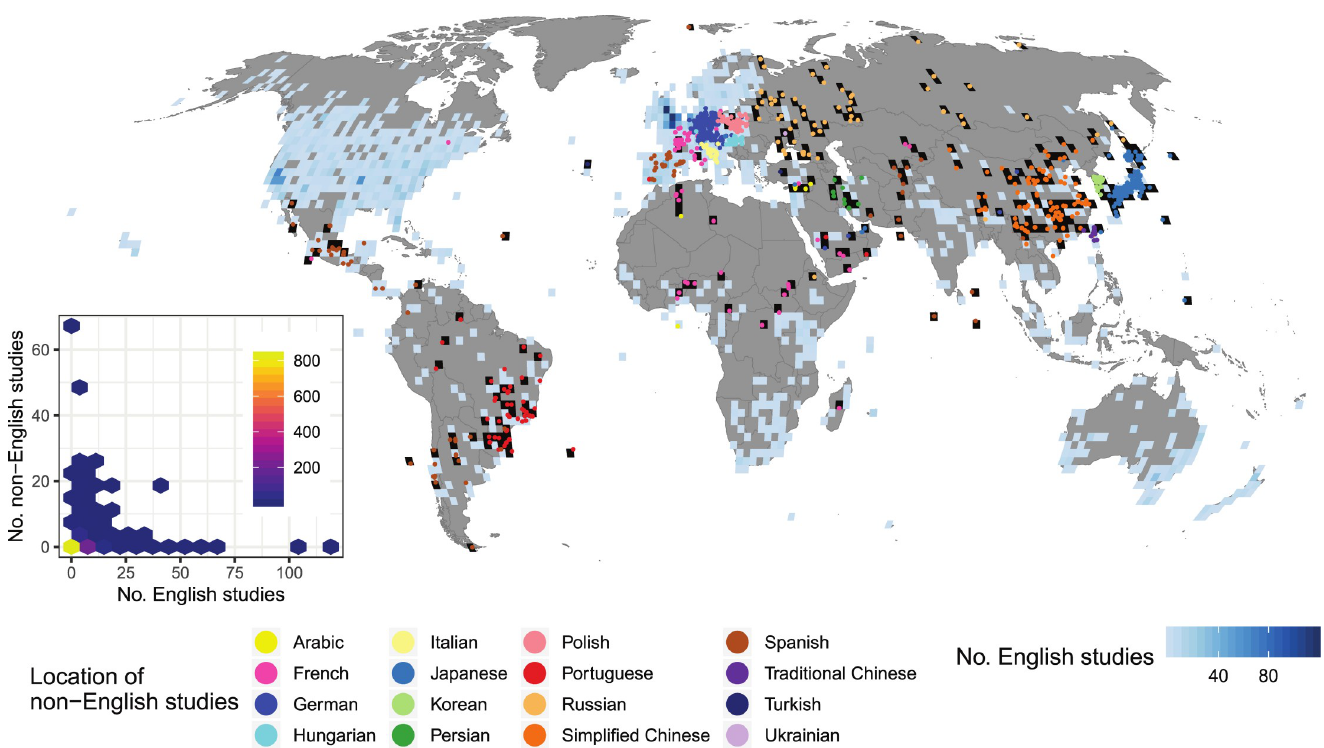
Fig 3. The location of 1,203 non-English-language studies with coordinate information, compared to the number of English-language studies testing the effectiveness of conservation interventions within each 2˚ × 2˚ grid cell (952 grid cells in total). Non-English-language studies were found in 353 grid cells, 238 of which were without any English-language studies (grid cells in black). The inset is a hexbin chart showing a negative (although nonsignificant) relationship between the number of English-language studies and the number of non-English-language studies (No. non-English studies) within each grid cell. Brighter colours indicate more grid cells in each hexagon. This figure was created using S3 and S4 Data with Code 3. Map produced from the Natural Earth dataset (v.4.1.0) at 1:50 m scale (https://www.naturalearthdata.com/downloads/50m-cultural-vectors/).